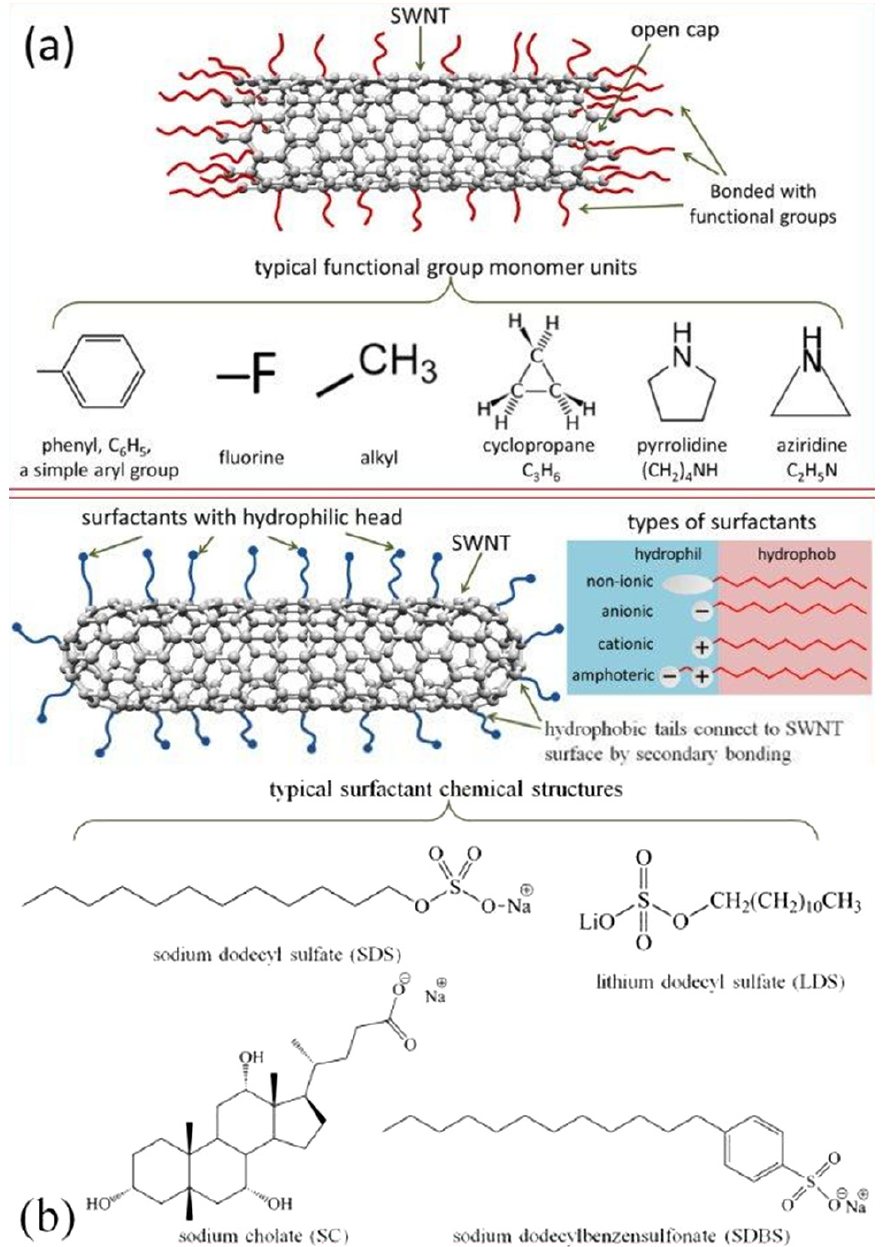
Figure 7. ( a ) Schematic representation of SWNT functionalization by covalent